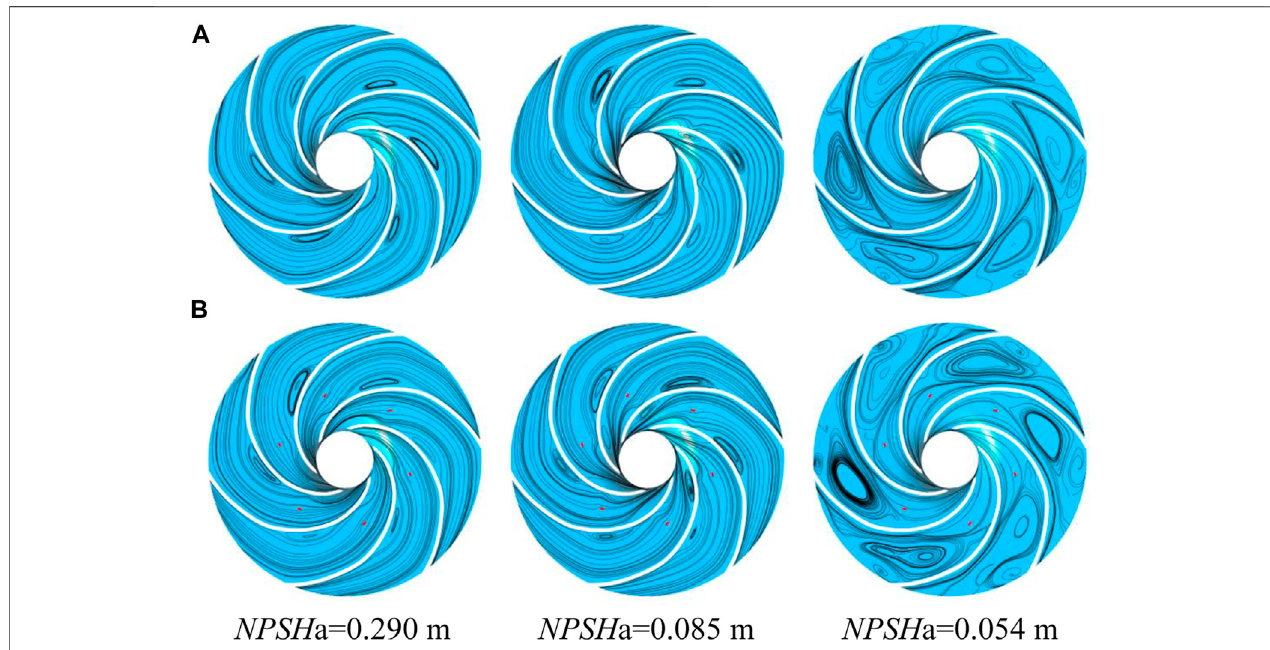
FIGURE 12 | Distribution of streamline: (A) original impeller and (B) B3 impeller.